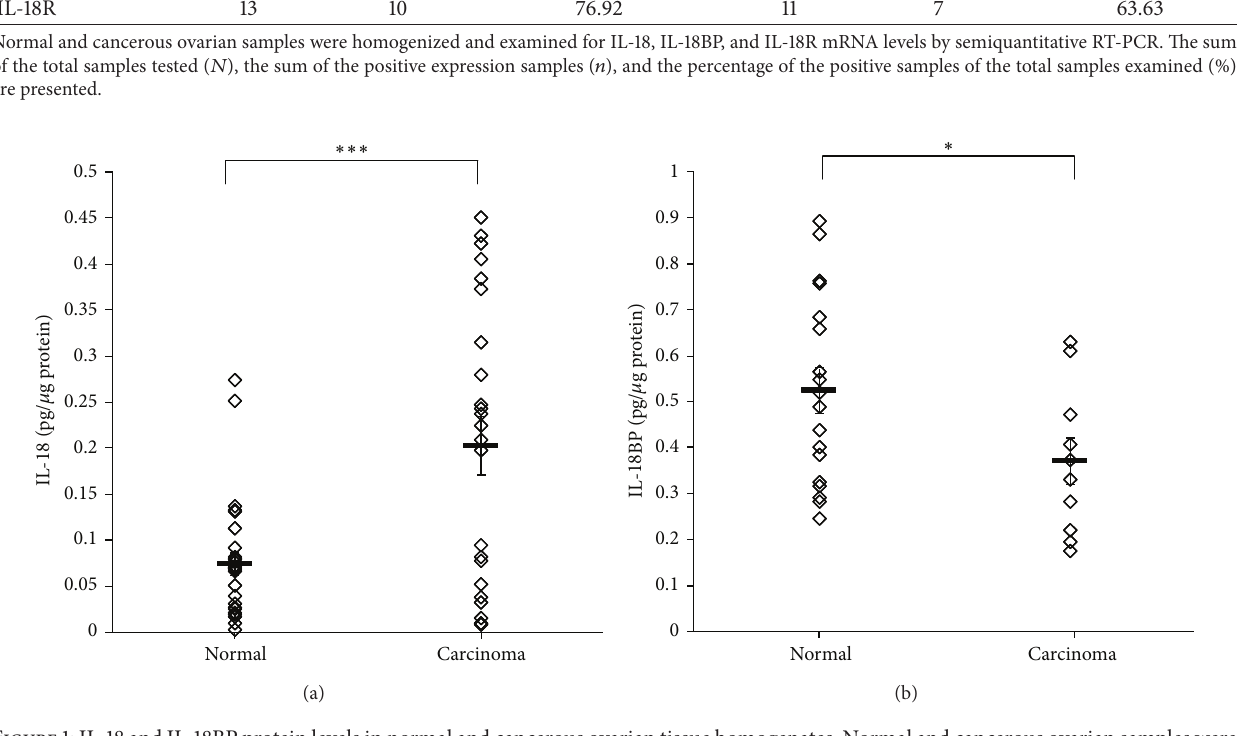
Figure 1: IL-18 and IL-18BP protein levels in normal and cancerous ovarian tissue homogenates. Normal and cancerous ovarian samples were homogenized. IL-18 (a) and IL-18BP (b) protein levels were evaluated by specific ELISA kits. Levels are expressed as pg/ 𝜇 g protein; each point represents one of the positive samples; 𝑛 = 28 (normal) and 24 (carcinoma) in (a) and 18 (normal) and 10 (carcinoma) in (b). Horizontal lines indicate MEAN ± SEM. ∗ / ∗∗∗ indicates statistical significance according to 𝑡 -test: ∗ 𝑃 = 0.04 ; ∗∗∗ 𝑃 = 0.0007 .